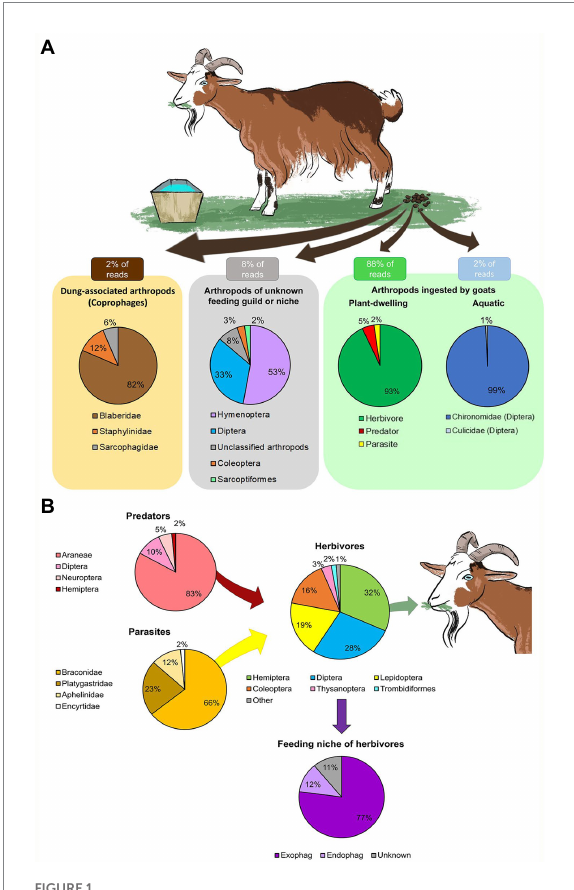
FIGURE 1 Overall diversity of arthropods ingested by goats. The mean proportion of reads (RRA) detected in the feces was averaged across February–June. Arthropods with few reads were grouped as “other.” (A) The main functional feeding groups of arthropods detected in the goat feces. Most of the RRA belonged to arthropods ingested while grazing (plant-dwelling). A small proportion of the RRA belonged to arthropods of unknown feeding group or niche, dung-associated arthropods (likely a contamination during collection) and aquatic arthropods (ingested while drinking). (B) Assembly of plant-dwelling arthropods detected in the goat feces, including the feeding niche of ingested herbivores (exophages–feed on the plant surface; endophages–feed within plant parts).